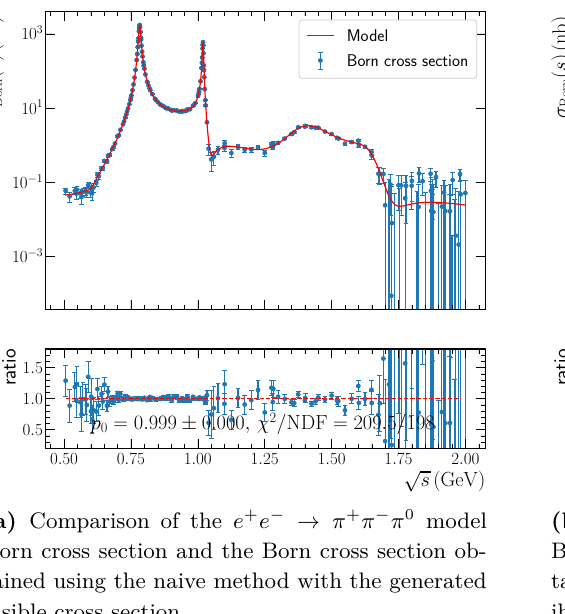
(a) Comparison of the e + e − → π + π − π 0 model Born cross section and the Born cross section ob- tained using the naive method with the generated visible cross section. Figure 7. Comparison of the e + e − → π + π − π 0 model Born cross section with the Born cross section obtained using the naive method. The results shown in this figure are obtained using mixed interpolation.